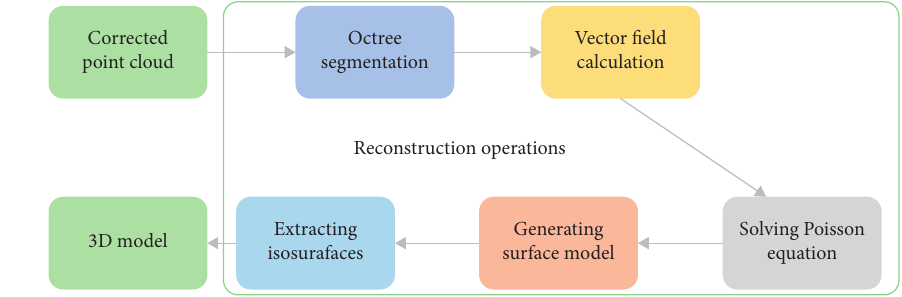
Figure 16: Poisson surface reconstruction algorithm. Table 1: Specimen 1 calibration parameters.